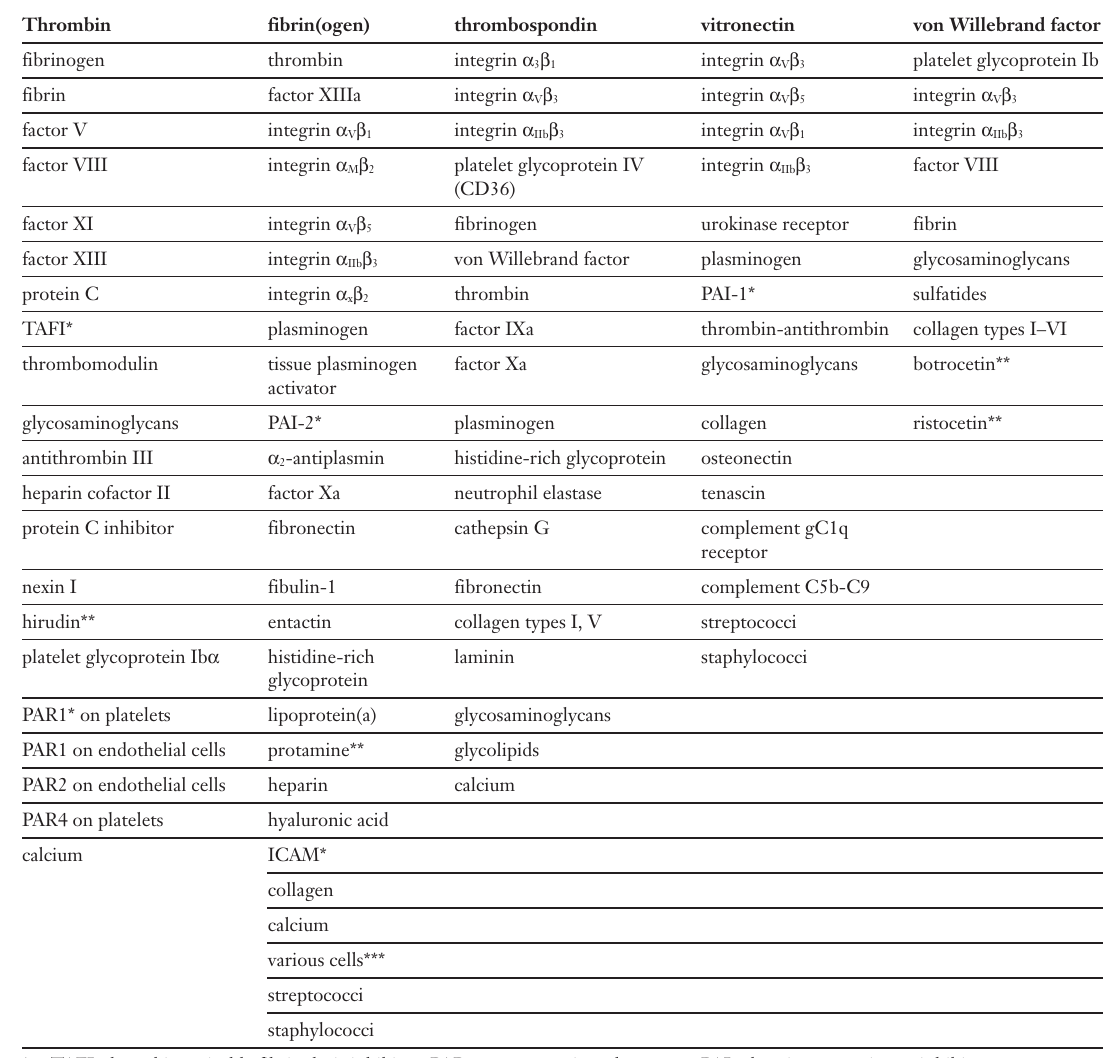
Table 2 Multiple ligands of some representative proteins involved in